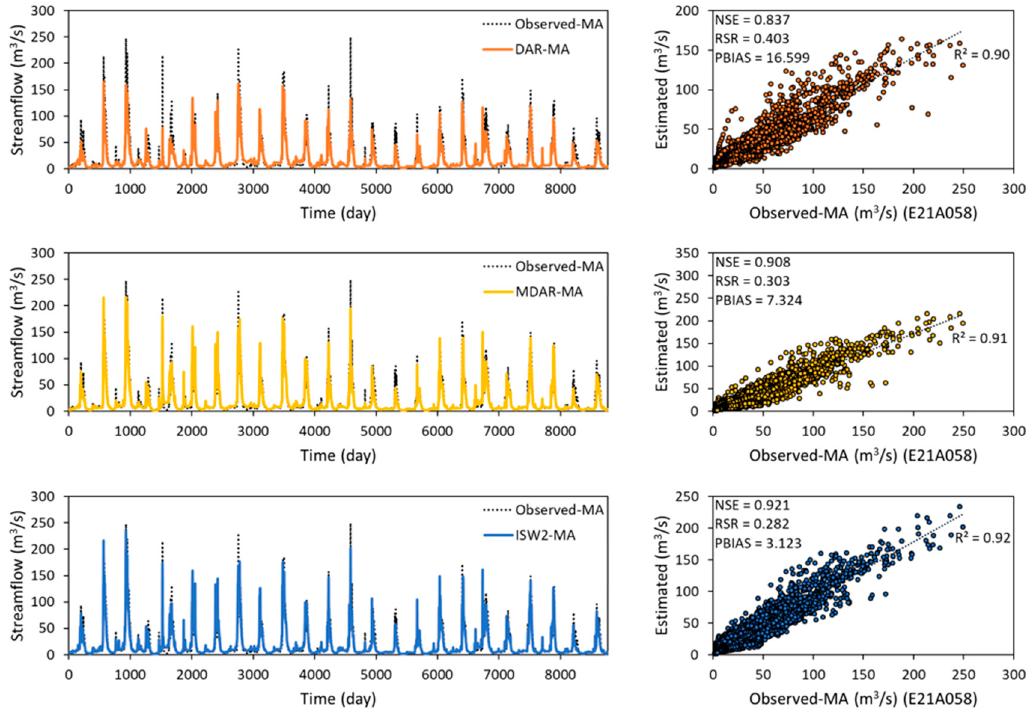
Figure 7. Comparison of daily streamflow estimated using DAR-MA (top row), MDAR-MA (mid row), and ISW2-MA (bottom row) with observed-MA (smoothed) daily streamflow at station E21A058 in the Middle Euphrates Basin.